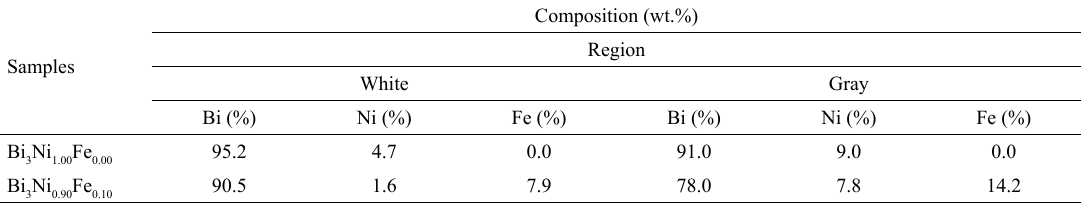
Table 2. Local composition of the Bi The EDS analyses were performed in areas of 4 x 4 μm 2 . Samples